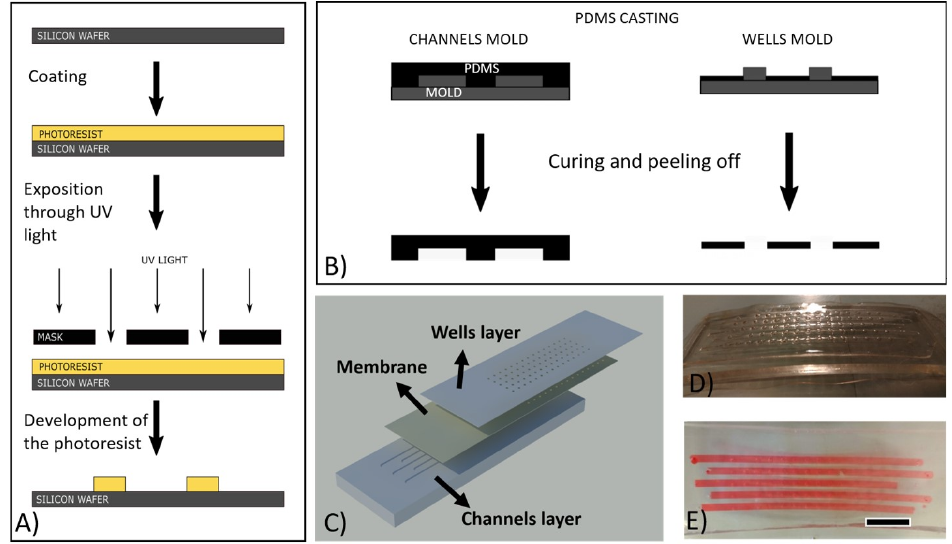
Figure 1. ( A ) Mold fabrication by photolithography process: SU8 photoresist deposition on Si wafer; exposition of the designed mask to UV light; development of the SU8 photoresist to attain the final mold. ( B ) The SU8 molds were used for the fabrication of both PDMS compartments by casting. ( C ) AutoCAD image showing the different components of the microdevice, i.e., channel layer (on the bottom), membrane (in between layers), and the wells layer (at the top). ( D ) Photo of the fabricated microdevice. ( E ) Photo showing a top view of the fabricated microdevice (the channel layer was filled with a molecular dye solution to highlight the presence of the channels, their geometry, and dimension. The scale bar in figure ( E ) corresponds to 1 cm.